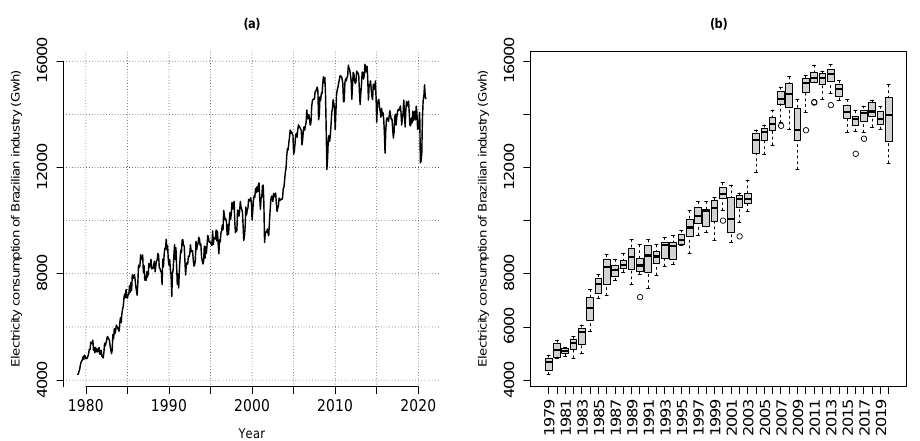
Figure 1. Electricity consumption ( a ) in GWh and ( b ) box-plots for the Brazilian industry. Source: Central Bank of